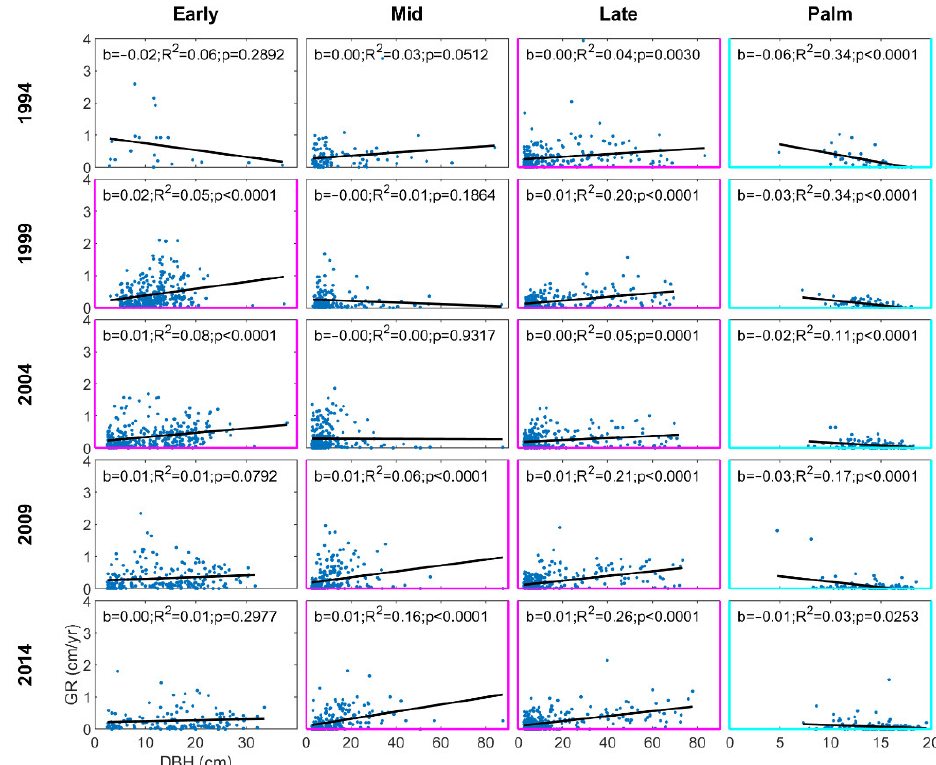
Figure 2. Scatter plots of diameter (DBH) growth rates (GR, cm per year) and DBH values (cm) for the four PFTs in the five censuses at Bisley Experimental Watersheds, Luquillo, Puerto Rico. The linear regression of GR on DBH for each PFT and census is estimated, and the regression coefficient (b), the coefficient of determination (R 2 ), and the p -value are shown in the panels. Linear regression models that are significant at 95% confidence interval ( p < 0.05) are identified with a blue box for negative regression coefficient and a magenta for positive coefficient. Grey boxes do not have statistically significant coefficients.